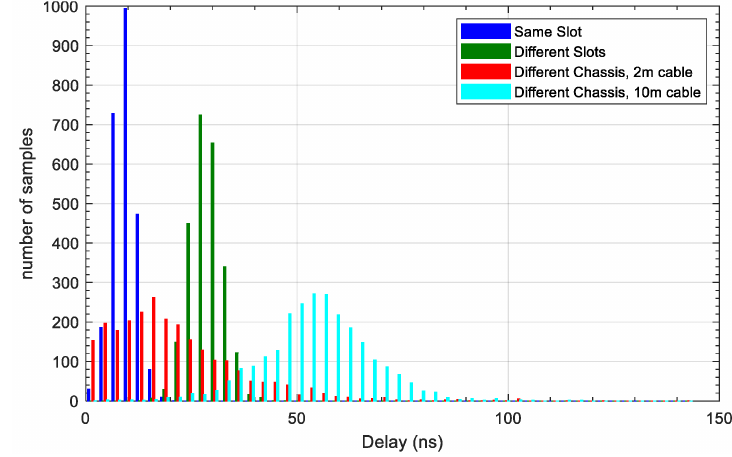
Figure 6. Histograms for phase measurements with Sigma-Delta modules.